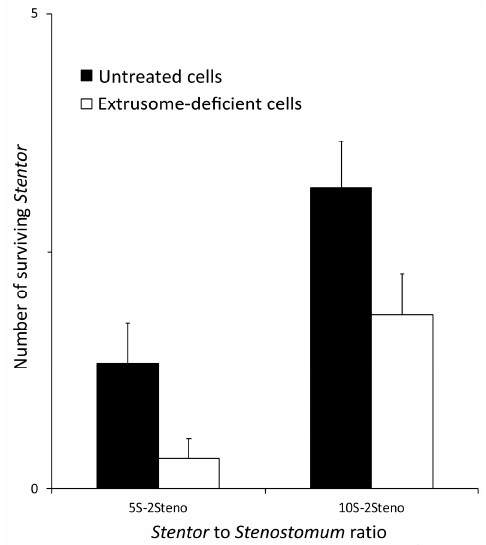
Figure 6. Effect of the extrusome deprivation in S. polymorphus obtained after the cold-shock treatment on the predator-prey interaction with S. sphagnetorum . Groups of five or 10 cells of either the extrusome-deficient (ED) or untreated cells of S. polymorphus were mixed with two specimens of S. sphagnetorum (the 5S-2Steno and 10S-2Steno respectively). Each bar represents the mean ( ± SE) of six independent experiments.